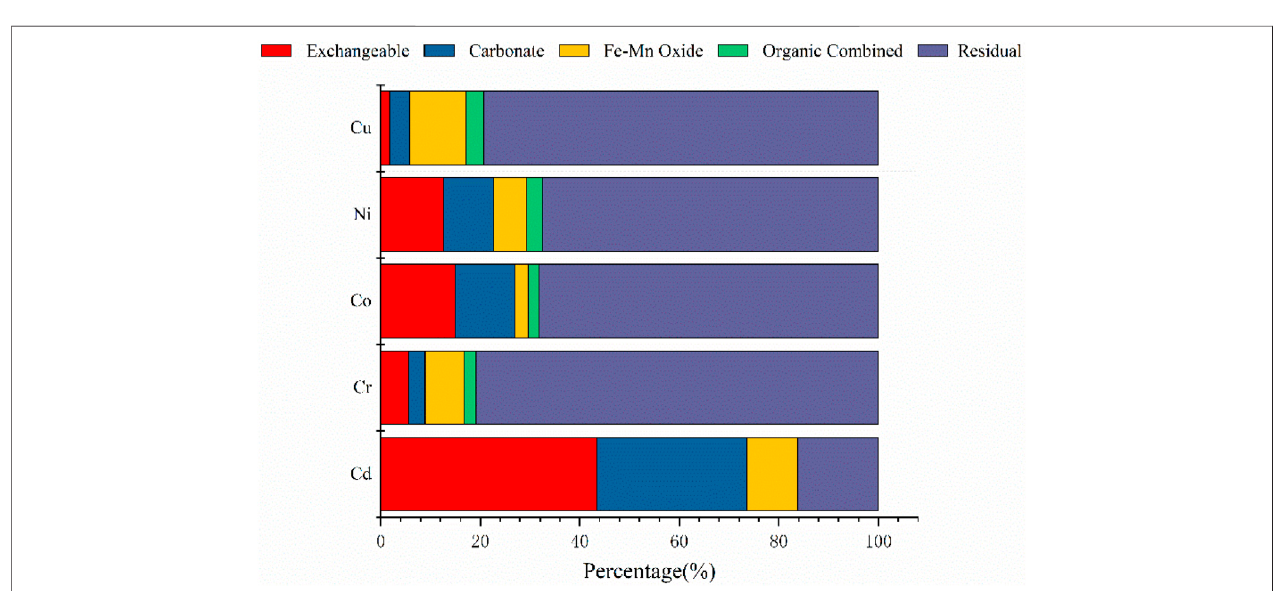
FIGURE 3 | Chemical fractionation of metals in fl y